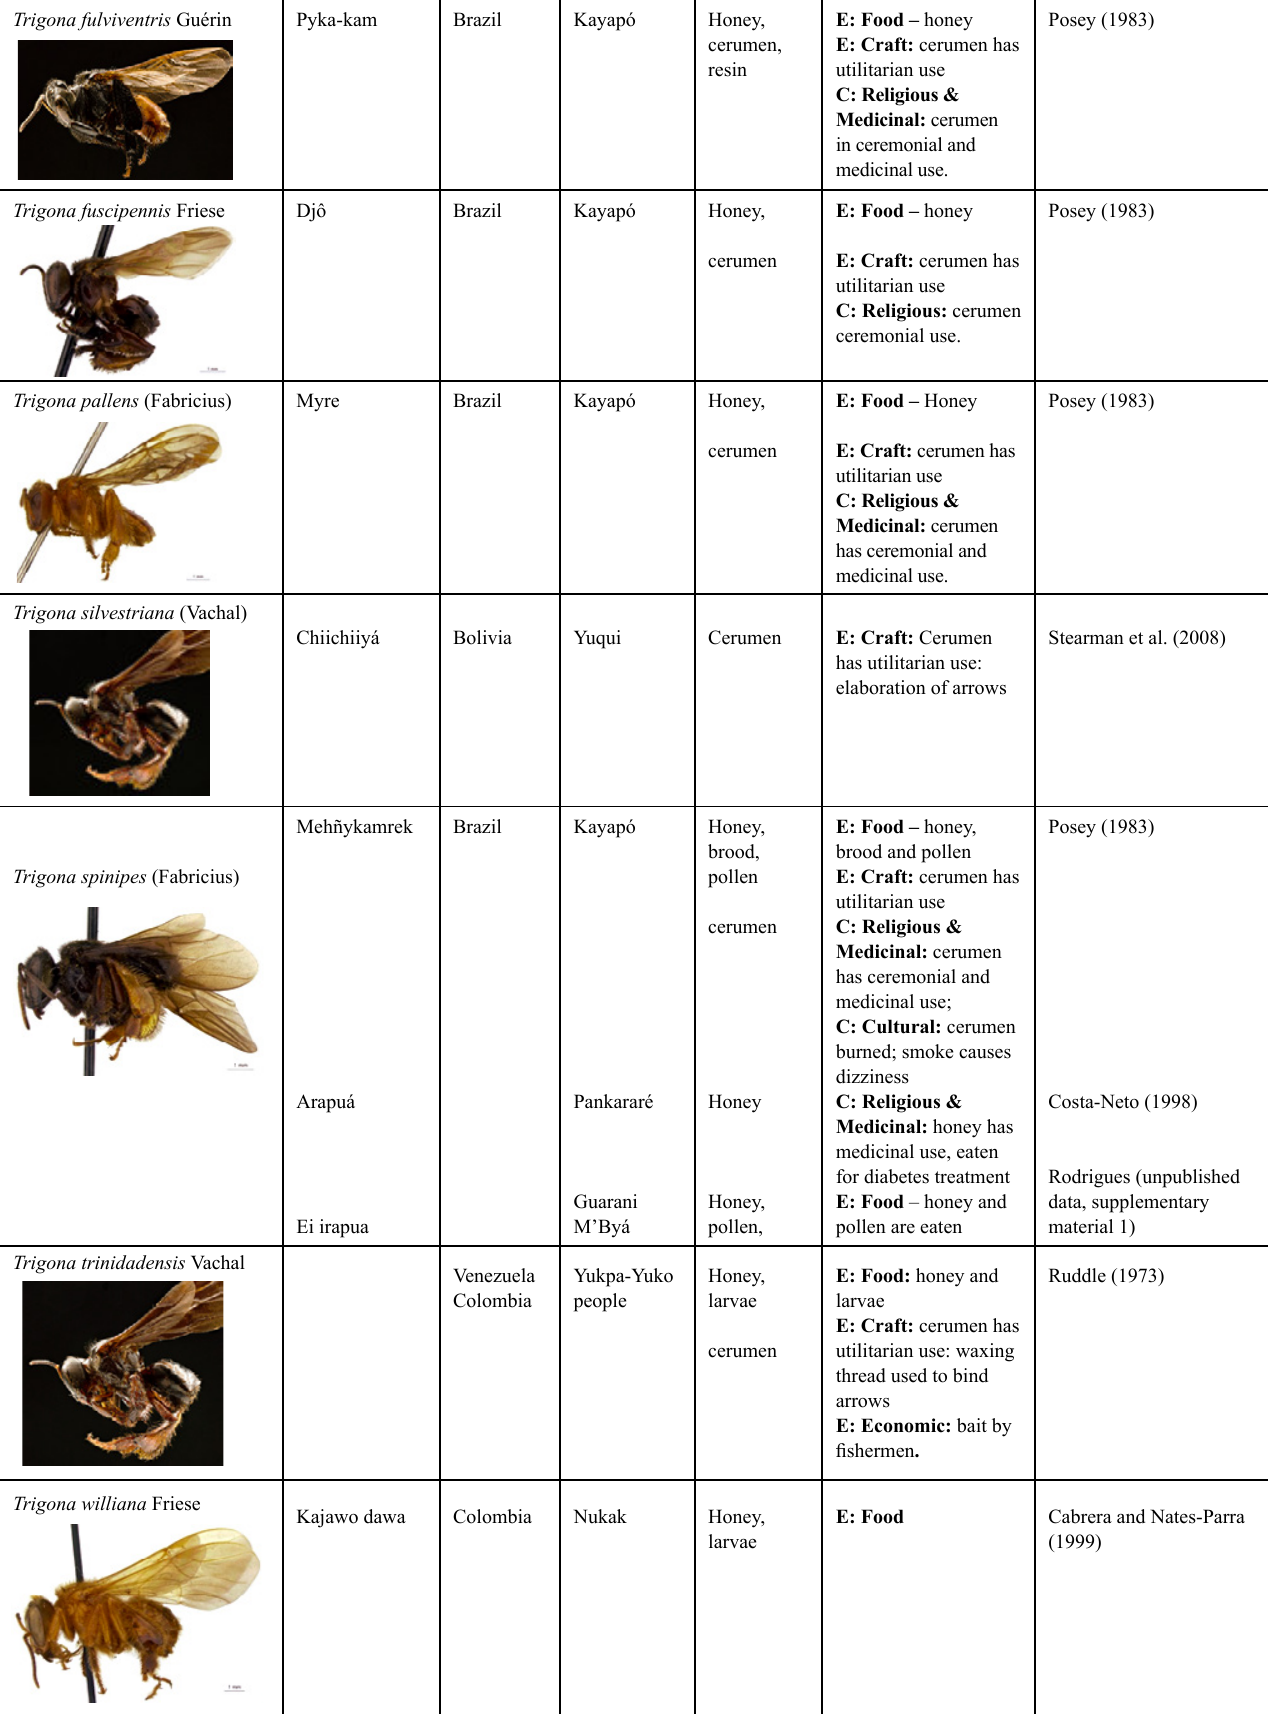
Brazil Kayapó Honey, cerumen, resin